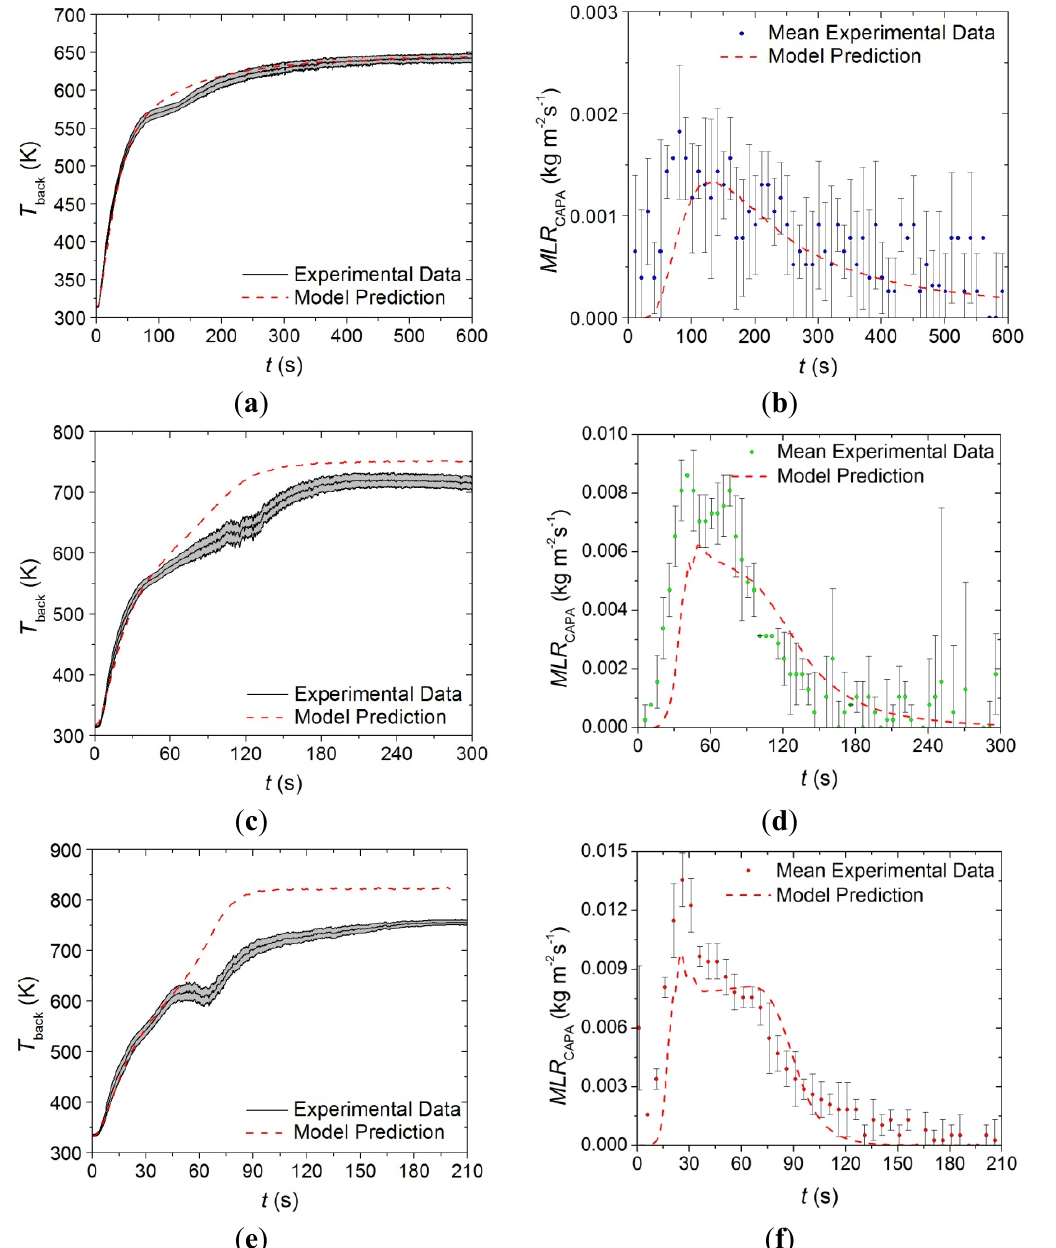
Figure 16. Experimental T back and MLR curves collected in CAPA tests and corresponding model predicted curves for the base layer exposed to radiant fluxes of ( a ) and ( b ) 30 kW·m − 2 , ( c ) and ( d ) 50 kW·m − 2 , and ( e ) and ( f ) 70 kW·m − 2 . The shaded region and error bars correspond to two standard deviations of the mean experimental data.